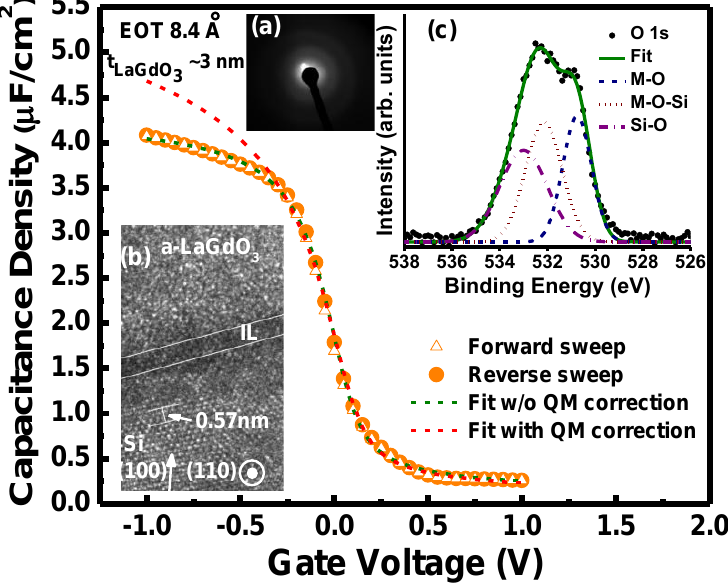
Figure 15. C - V plots of Pt/LaGdO /p-Si high-k metal gate devices recorded at 100 kHz, 3 including its Hauser fit with and without quantum mechanical (QM) correction. ( a ) Selective area electron diffraction image of amorphous LaGdO ; ( b ) cross-sectional 3 TEM image of the LaGdO /Si heterostructure fabricated at 300 °C; ( c ) ex situ O1s XPS 3 spectra from ~8 nm-thick LaGdO film on Si after Ar+ sputtering etches. Reprinted with 3 permission from [17]. Copyright 2013 AIP Publishing LLC.